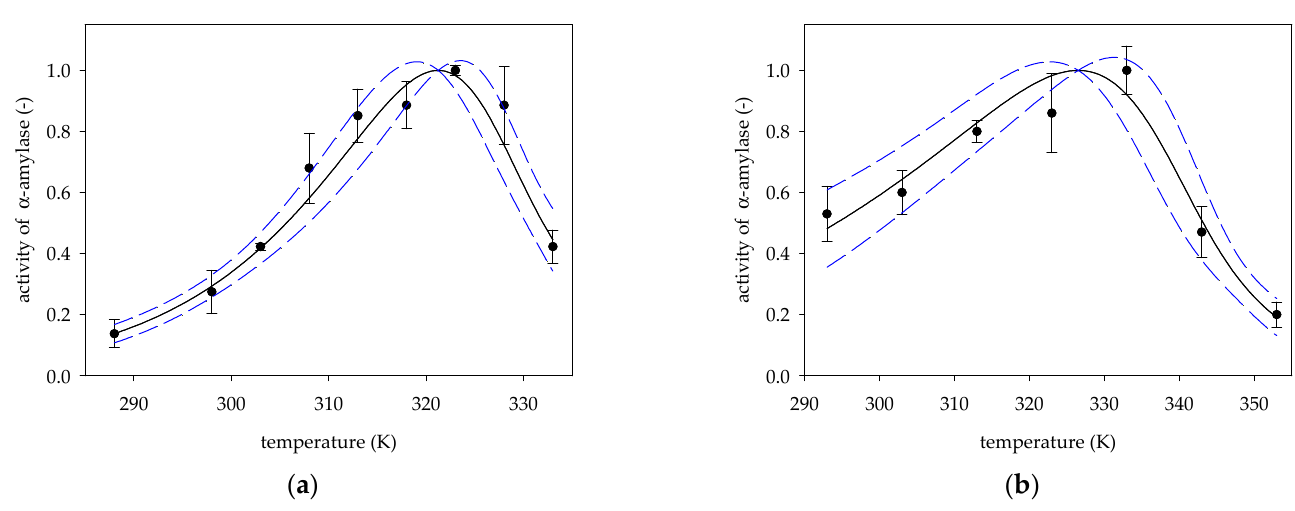
Figure 3. The activity of α -amylase porcine pancreas by measurements: ( a ) Louati et al. [21]; ( b ) Guoet al. [22]; ( ● ) experimental data, (solid line) Equation (6); (dotted line) 95% confidence band. Table 2. The statistical data obtained by determining the kinetic parameters of α -amylase porcine pancreas.